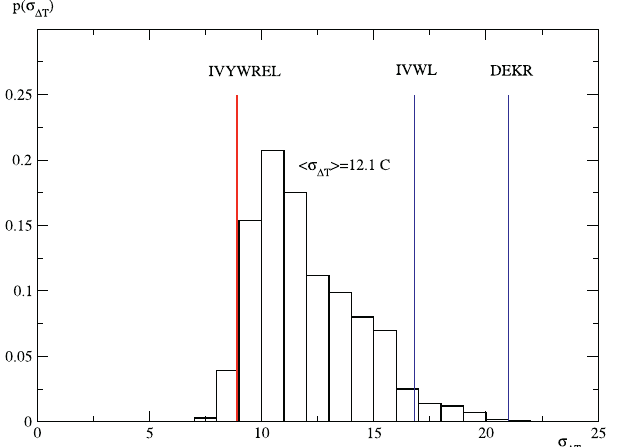
Figure 3. The Distribution of the Root-Mean-Square Error r D T of the Prediction of the OGT in the 1,000 43-Species Test Sets (Black), and the Prediction Errors for 86 Organisms Using the IVYWREL Set (Red) or Sets of Charged or Hydrophobic Residues (Blue) Individually, sets of hydrophobic or charged residues provide a much lower precision than their proper combination, IVYWREL.